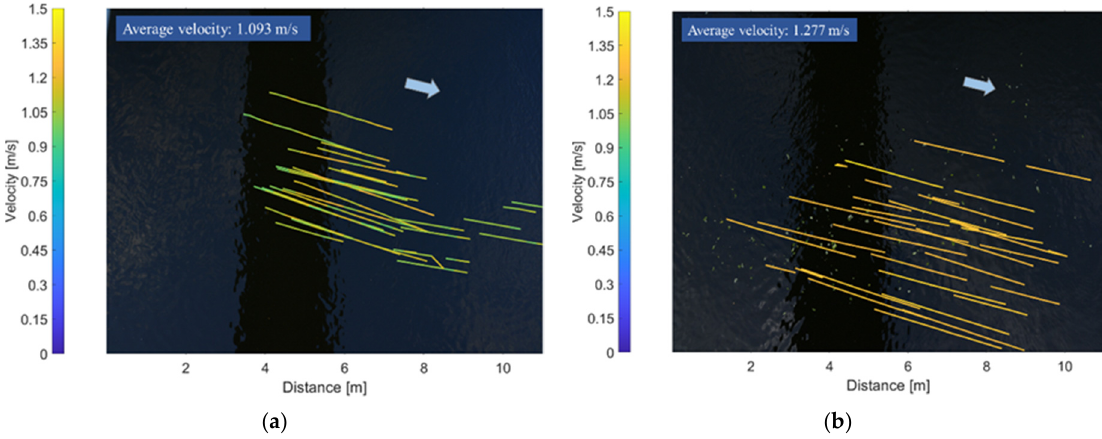
Figure 6. Surface velocity of the field measurements: ( a ) Measurement 1 (Record time: 3.50 s); ( b ) Measurement 2 (Record time: 3.70 s).